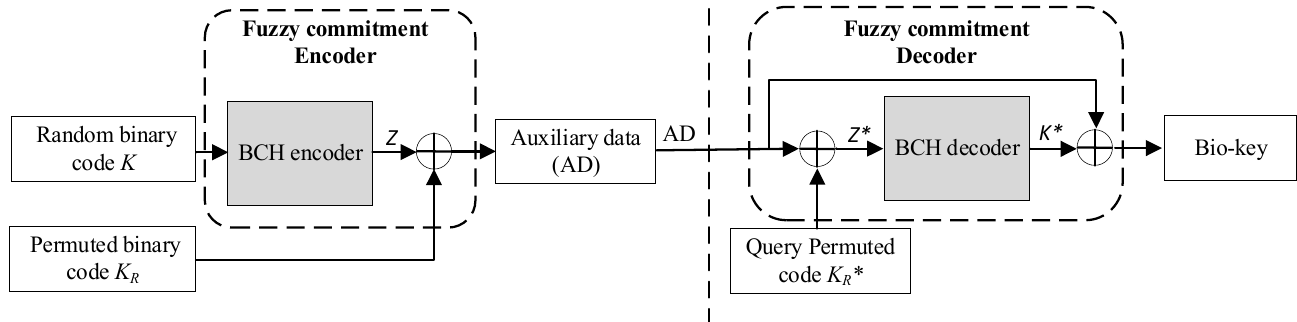
Figure 6. The implementation process of the fuzzy commitment. During the encoder stage, binary codes 𝐾 𝑅 and 𝐾 are encoded to auxiliary data AD through the fuzzy commitment encoder. During the decoder stage, the bio-key is decoded with the help of the AD and query permuted code 𝐾 𝑅∗ through the fuzzy commitment decoder.